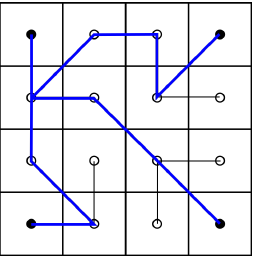
Figure 5: The tree T 2,1 (in blue) for the IFS for the square in Fig.